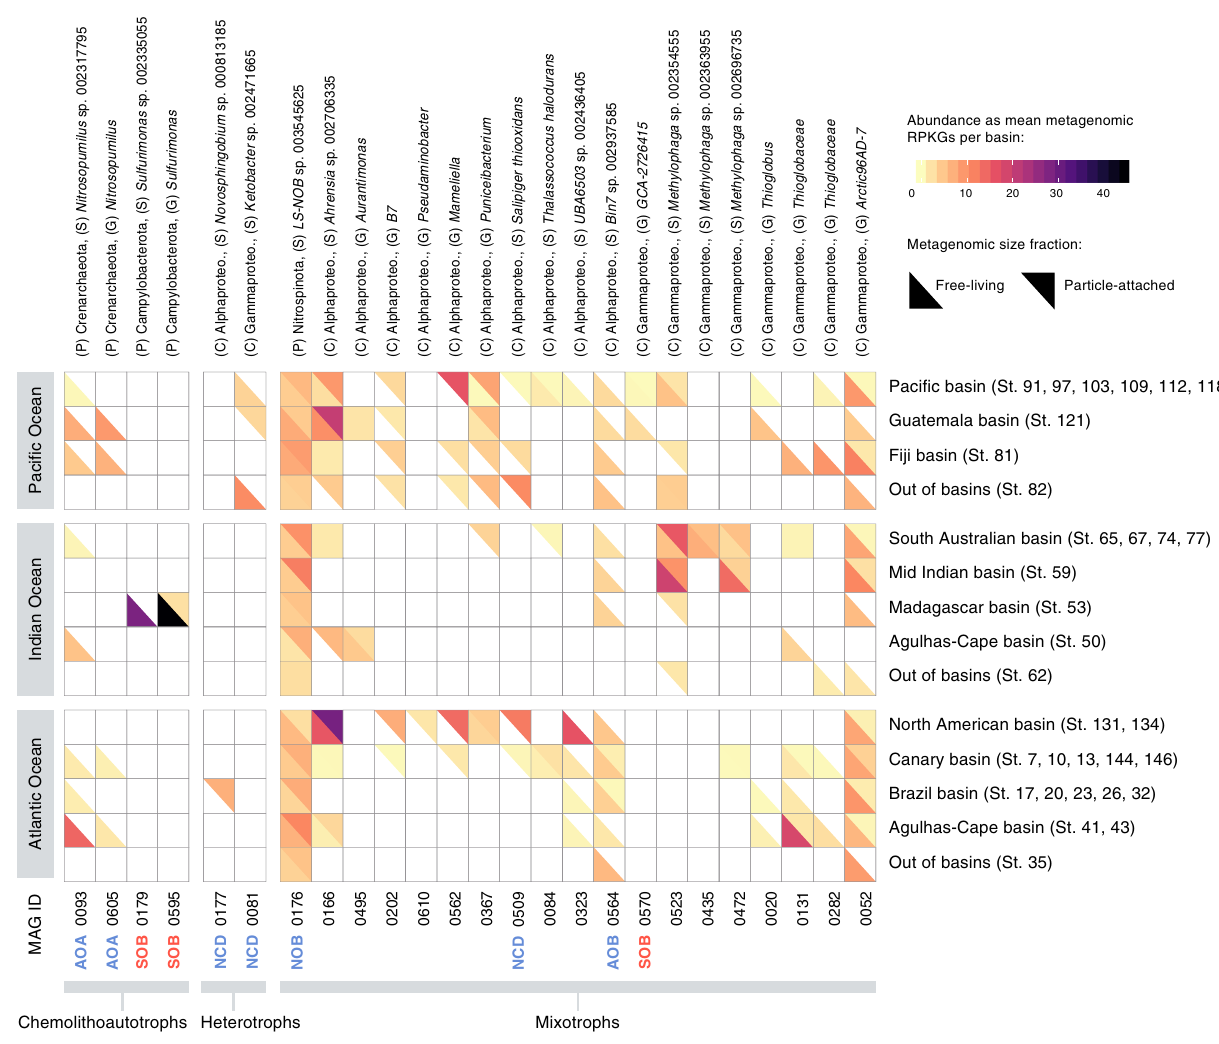
Fig. 7 Mean abundance of 25 selected MAGs per oceanographic basin and size fraction, represented as metagenomic RPKGs (reads per genomic kilobase and metagenomic gigabase). The upper half-tile represents RPKGs from the particle-attached size fraction metagenomes (0.8 – 20 µ m) and the bottom half-tile represents RPKGs from the free-living size fraction metagenomes (0.2 – 0.8 µ m). White represents the absence of the MAG in the metagenomic sample. MAGs are arranged based on their assigned metabolic strategy (chemolithoautotrophs, heterotrophs, and mixotrophs), and speci fi c metabolic pathways con fi rmed in previous analyses are prepended to each MAG ’ s ID following color codes from Fig. 6 (blue for nitrogen metabolism, red for sulfur metabolism; AOA ammonia-oxidizing archaea, SOB sulfur-oxidizing bacteria, NCDs non-cyanobacterial diazotrophs, NOB nitrite-oxidizing bacteria, AOB ammonia-oxidizing bacteria). Phylogenomic taxonomic assignation of MAGs is presented at the top of the fi